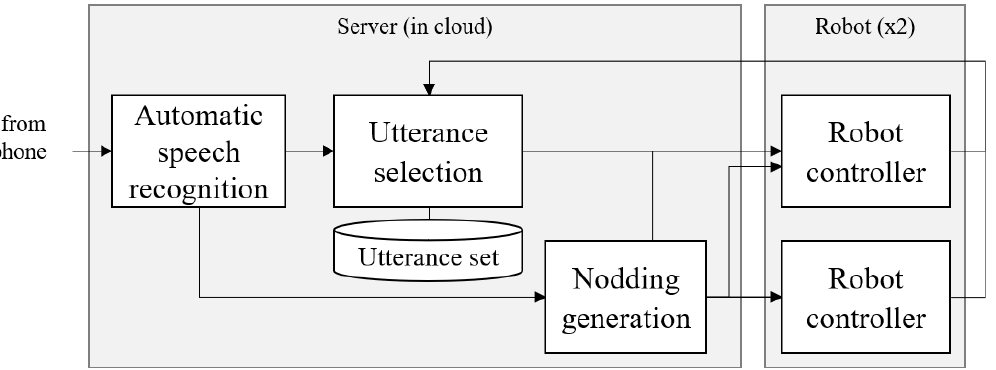
Figure 4. The system